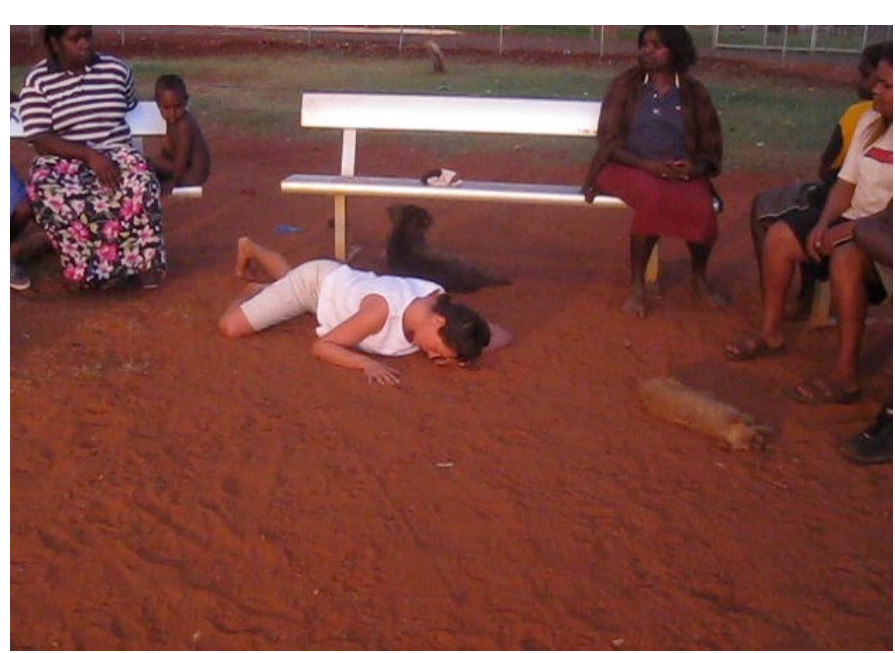
Figure 3. The dogs and me performing the ‘Book of Job’ at Owairtilla, 2008. Photo: Alex Pinder.